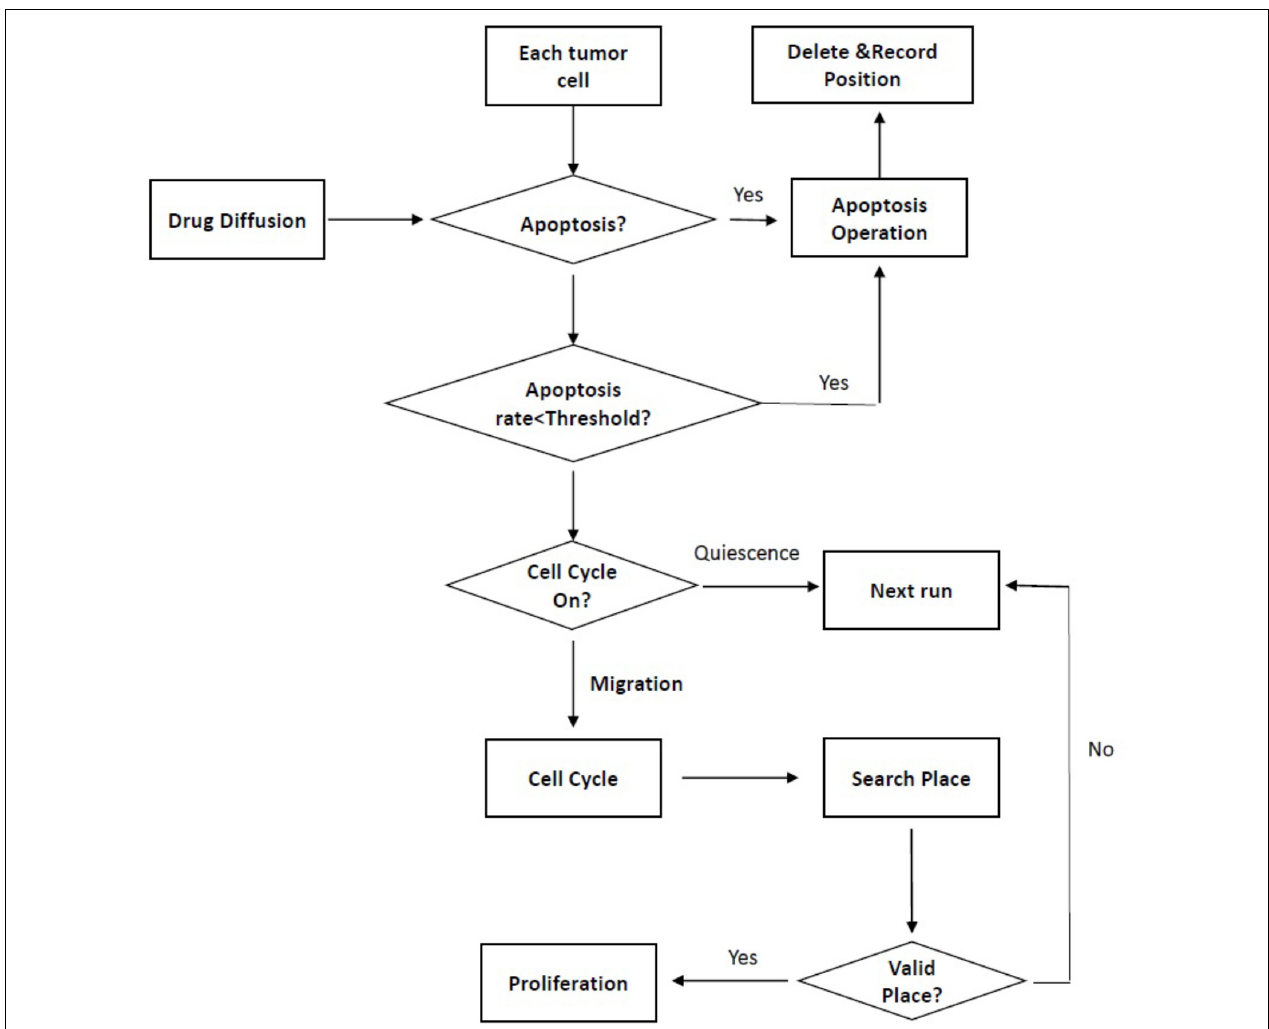
FIGURE 3 | The cellular phenotype switching at the intracellular scale. Apoptosis: Under the drug diffusion, the cell will initiate apoptosis if the simulated apoptosis probability is less than the set threshold. Proliferation: The proliferation will initiate if the cell cycle is on and empty location exist to divide in the mitotic M phase. Migration: A proliferating cell will migrate in the first three phases of cell cycle (G0/G1, S, and G2) under appropriate location. Quiescence: There are two possibilities of quiescence: the cell cannot go through the cell cycle, or the cell cannot find a valid place to